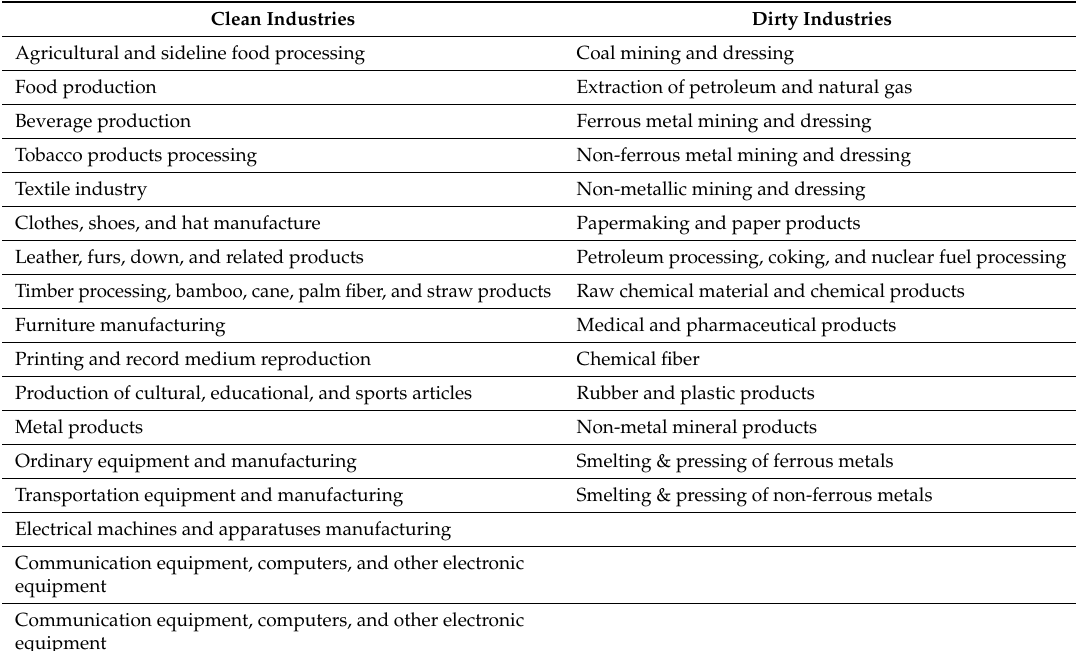
Table 2. Composition of industry